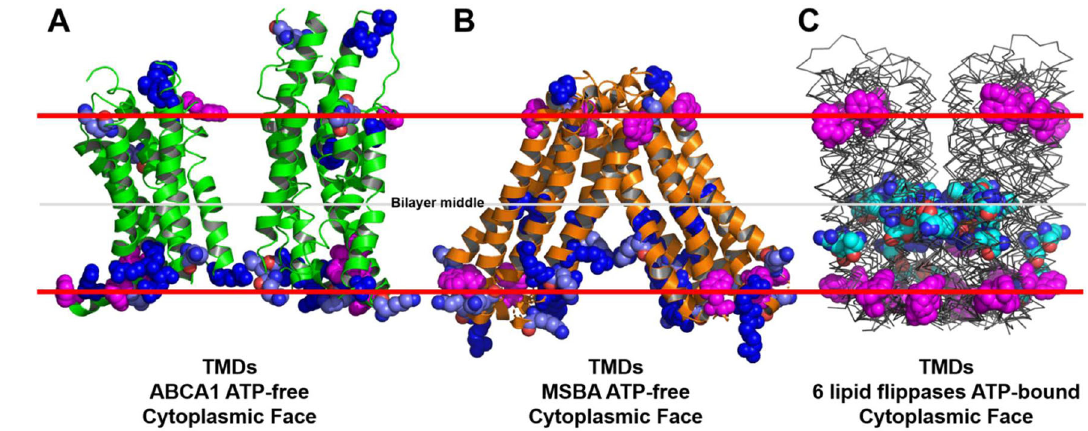
Fig. 8 | Basic residue distribution in the TMDs of ABCA1 and six established lipid fl ippases. The locations of tryptophan residues (space- fi lling magenta) are used to mark the membrane interfaces. In A , B , lysine residues and arginine resi- duesare paleblueand darkblue, respectively.In C ,intramembrane lysine residues